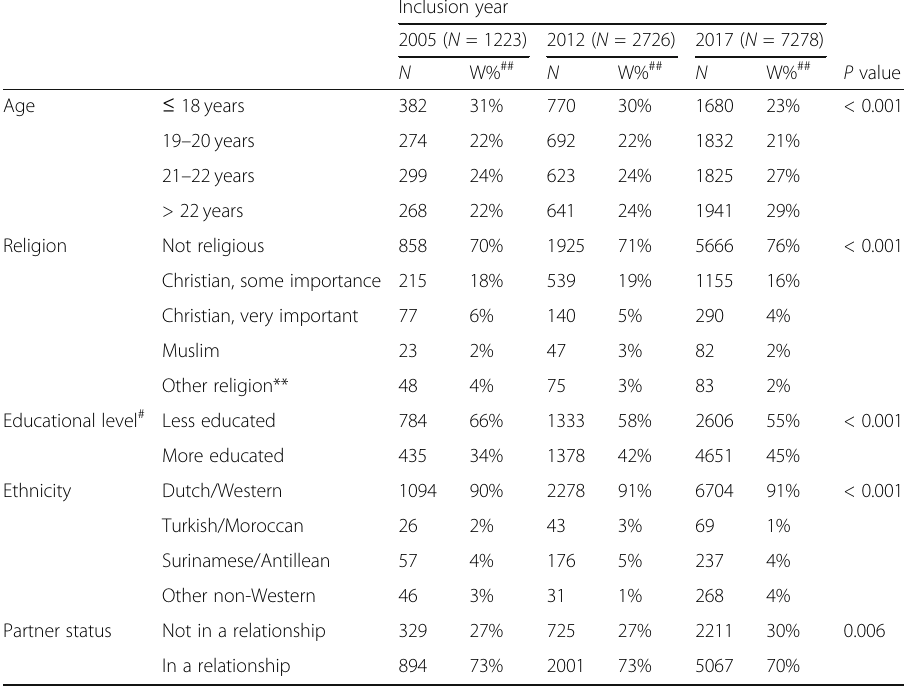
Table 1 Characteristics of the study population — Dutch girls aged 12 to 25 years who experienced at least once sexual